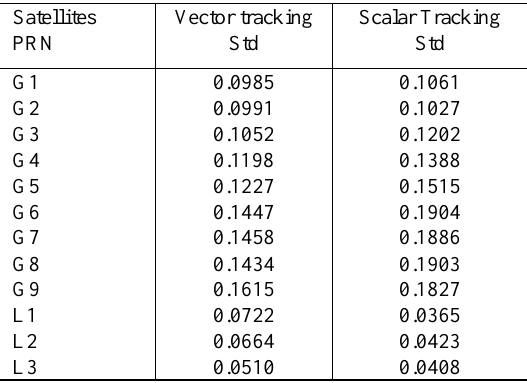
Table 3. Comparison of the standard deviation of the code phase error between VTL and